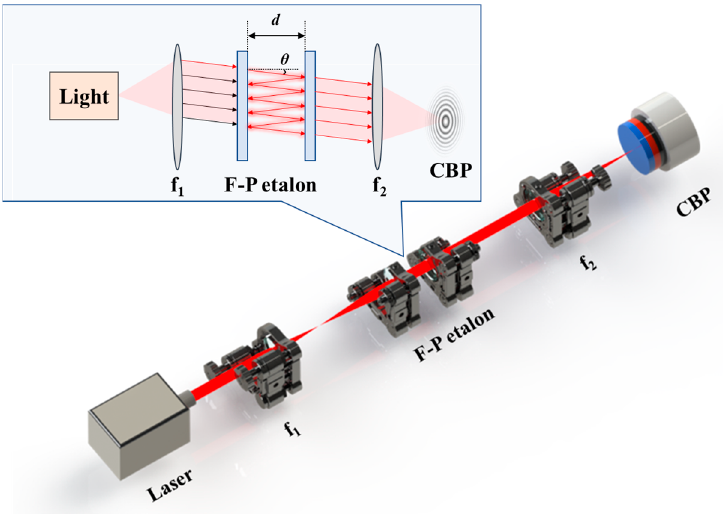
Figure 1. Schematic diagram of the experimental setup used for measurement of the laser linewidth. The interference circles generated by the FP etalon with 95% and 99.5% reflectivity are shown in Figure 2a,c, respectively, which will be further processed by computer. One row of data extracted from a straight line through the center of the circle is drawn as a scatter plot as shown in Figure 2b,d.